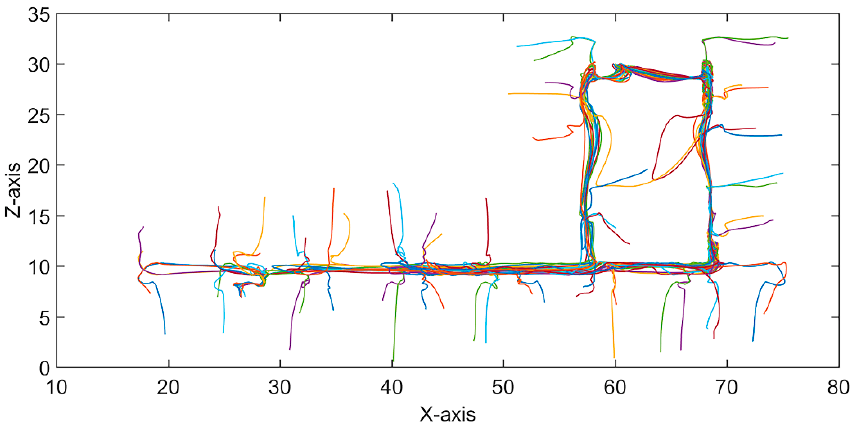
Figure 5. Visualization of evacuation paths.